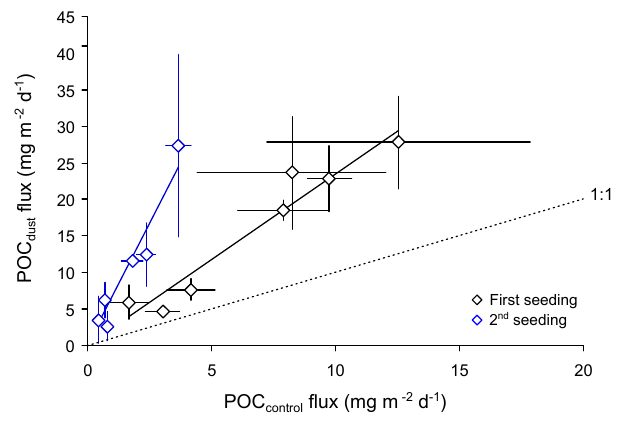
Fig. 7. POC dust versus POC control fluxes (mean fluxes and stan- dard deviations of the mesocosm triplicates). The best linear regressions and the 1 : 1 lines are shown. First seeding: N = 7, slope=2.33 ± 0.12, R 2 = 0 . 94, p < 0 . 0001 (Fisher test). Sec- ond seeding: N = 6, slope=6.68 ± 0.51, R 2 = 0 . 93, p < 0 . 0001 (Fisher